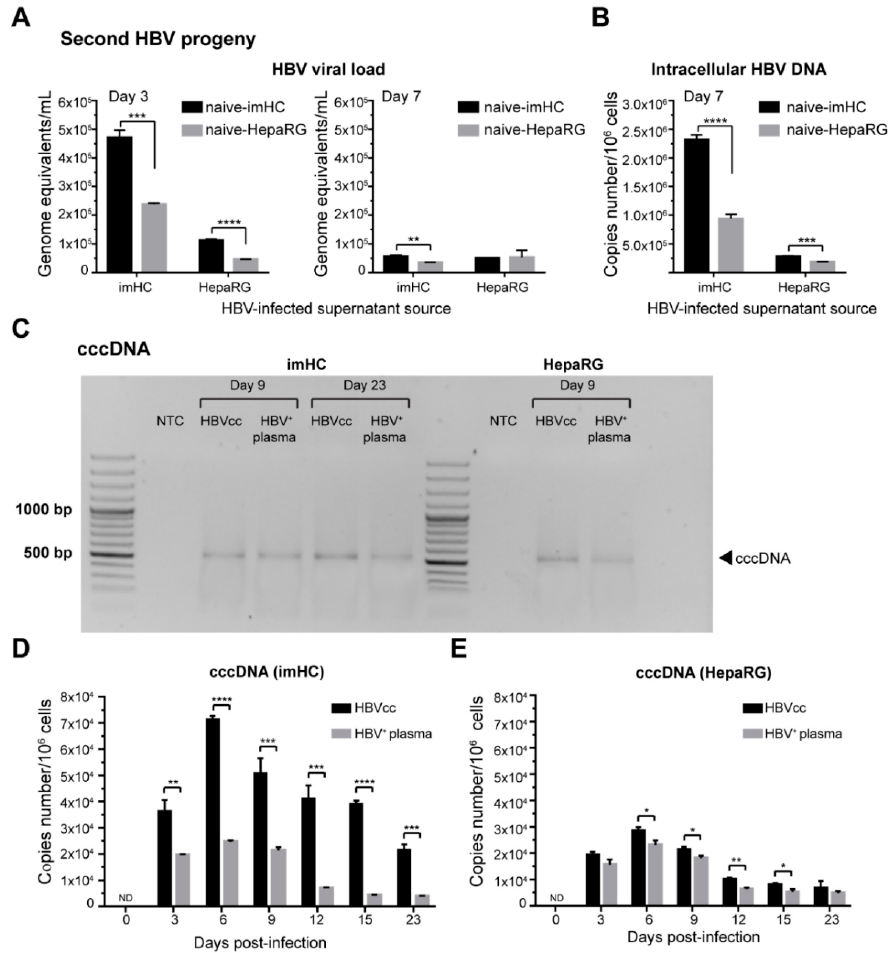
Figure 4. The imHCs infected with either HBVcc or HBV + plasma produced the second HBV progeny and accumulated a covalently closed circular DNA (cccDNA) pool. Naïve imHC and HepaRG were infected with conditioned medium collected from HBVcc infected hepatocytes and monitored for extracellular HBV (viral load) on days 3 and 7 ( A ), as well as intracellular HBV DNA on day 7 ( B ). The cccDNA PCR products were analyzed using agarose gel electrophoresis on day 9 and day 23 post-infection ( C ). The cccDNA pool in either imHCs ( D ) or HepaRG ( E ) after being infected with HBVcc or HBV + plasma was expressed as copies number /10 6 cells. Data are presented as mean ±